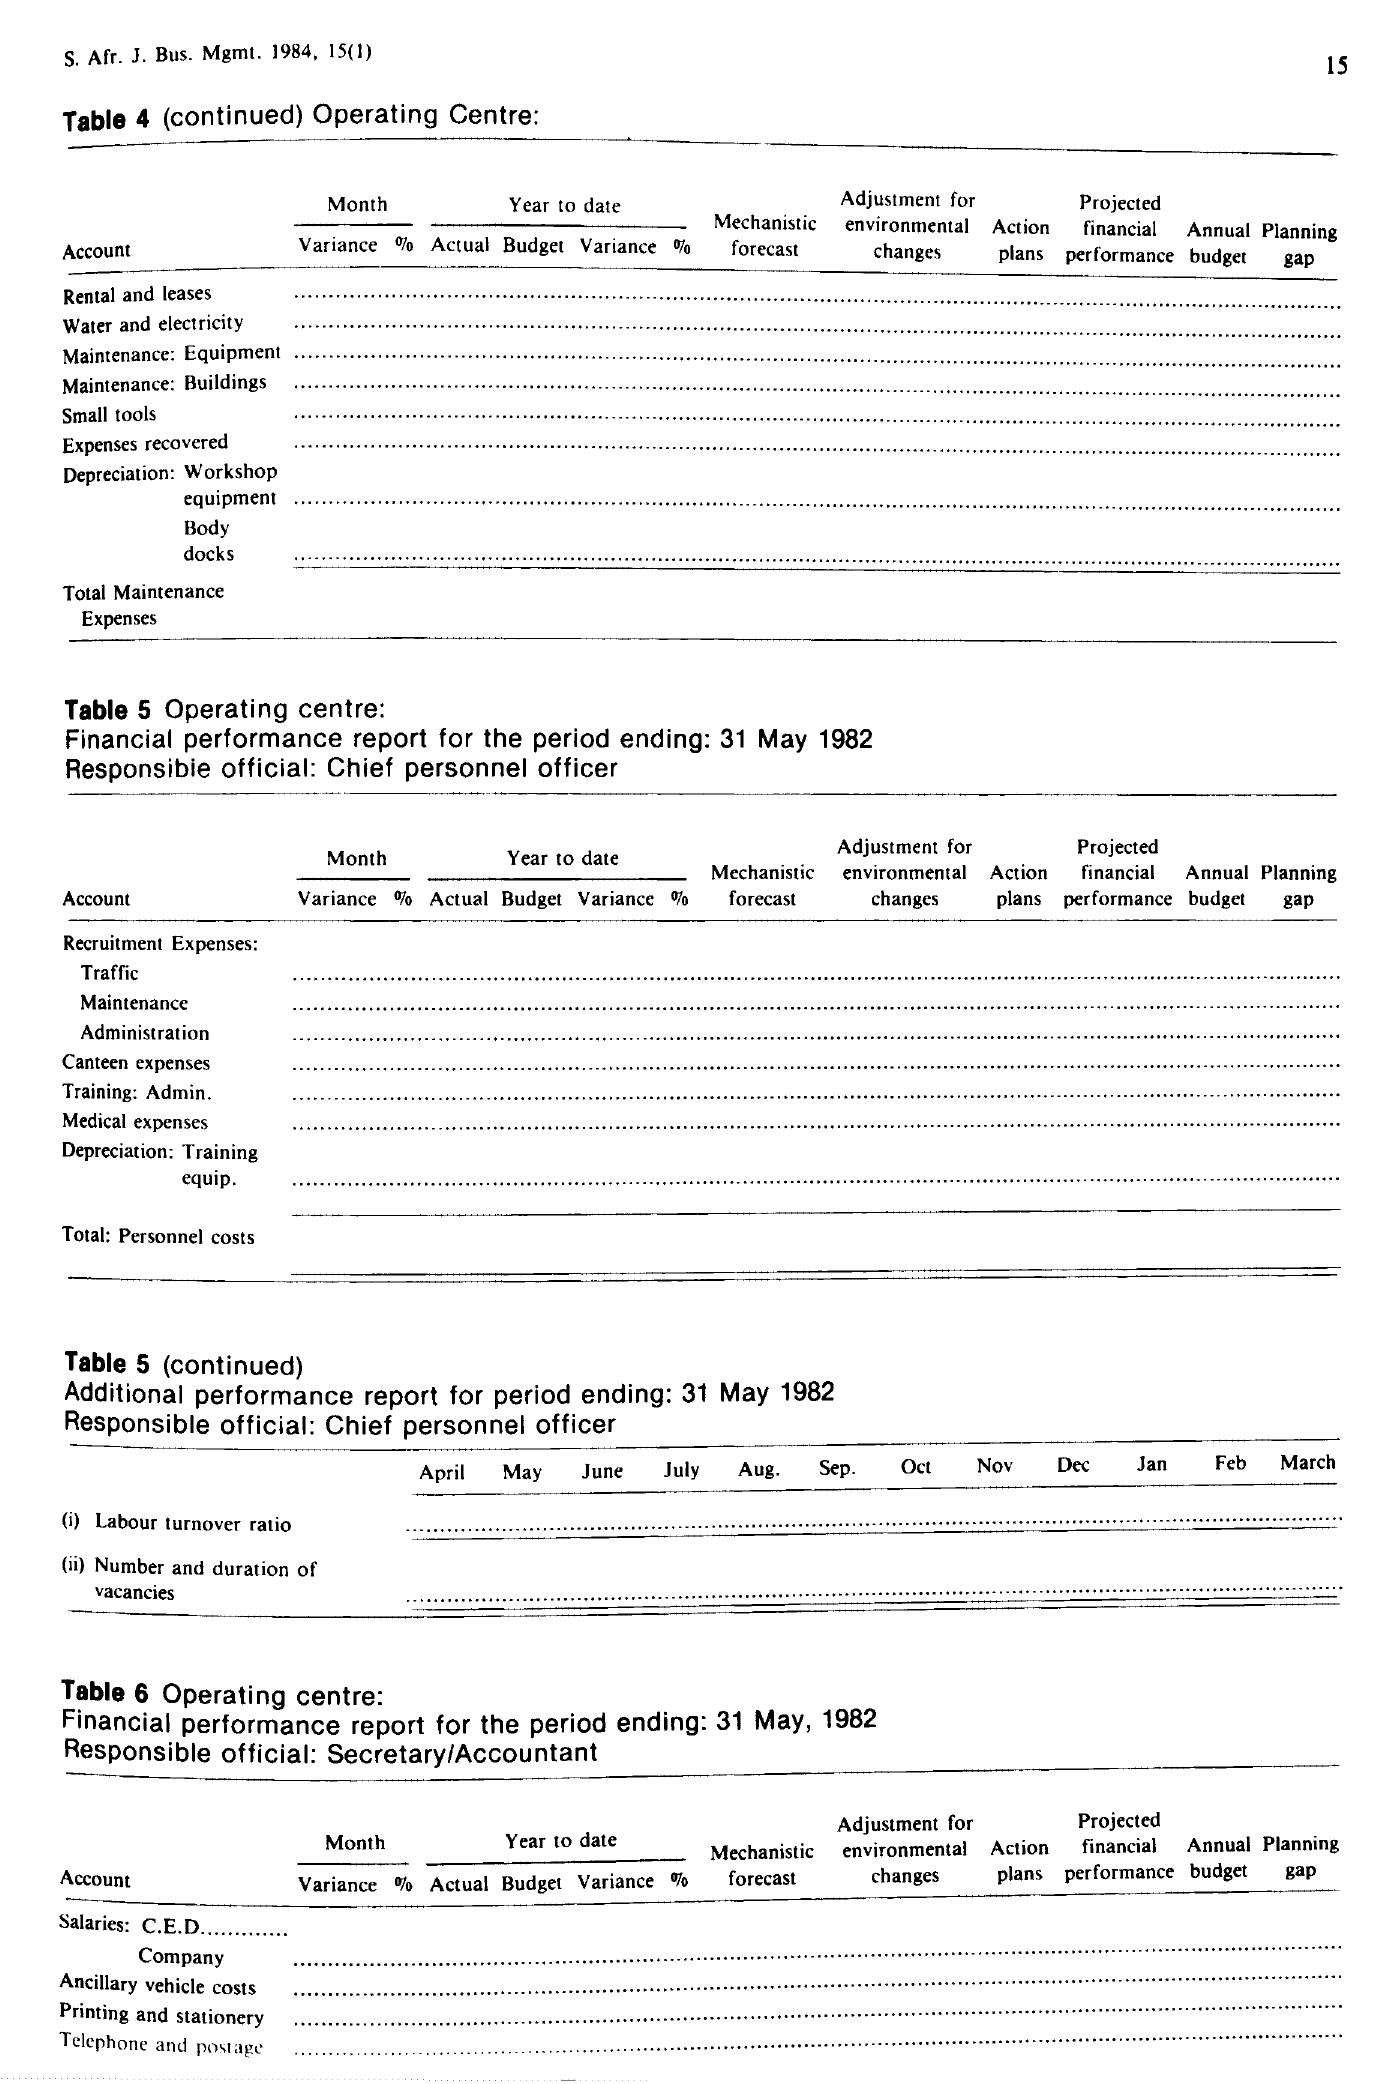
Table 6 Operating centre: Financial performance report for the period ending: 31 May, 1982 Responsible official: